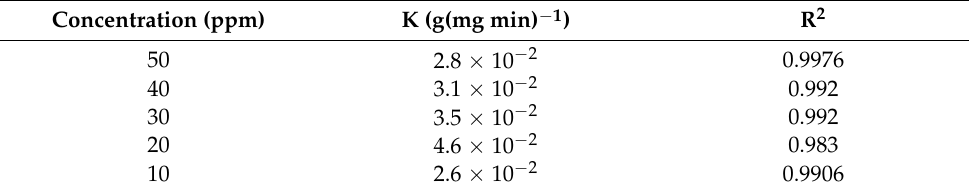
Figure 6. Pseudo–second-order kinetic model of Fe-MOFs on RhB ( a ) 50 mg, 20 °C; ( b ) 50 ppm, 20 °C. Table 1. The PSO parameters of Fe-MOFs with different concentrations of RhB.